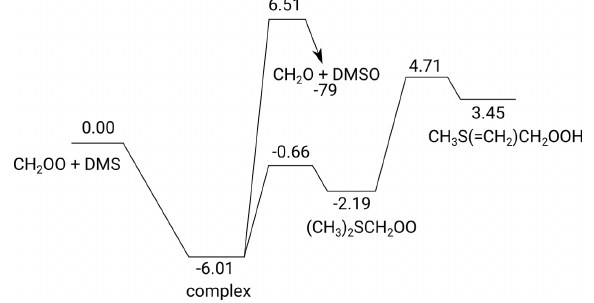
Figure 5. The potential energy surface of CH 2 OO + DMS (kcalmol − 1 ) , based on ZPE-corrected (ZPE signifies zero-point en- ergy) CCSD(T)//M06-2X relative